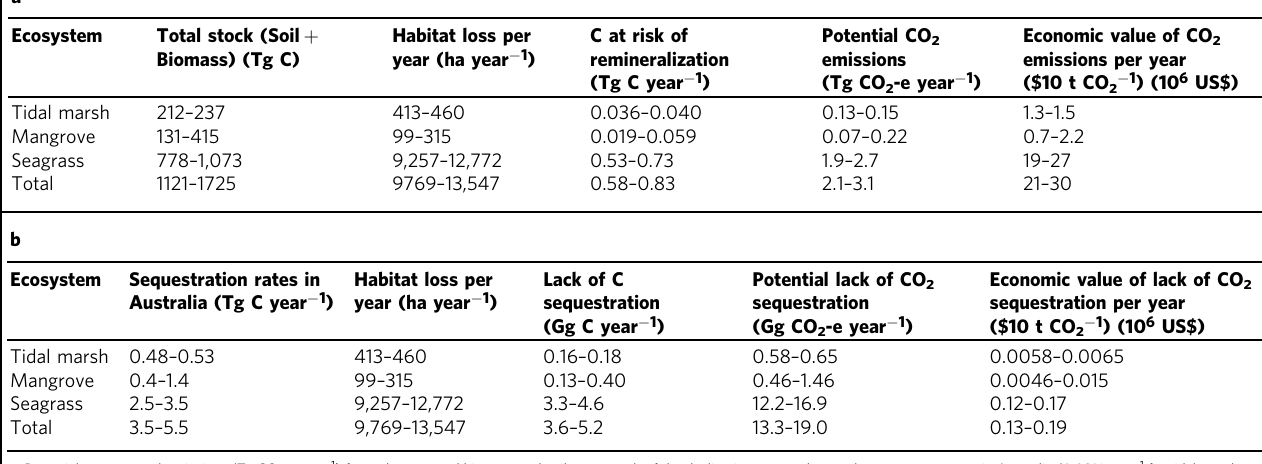
Table 3 Potential annual CO 2 emissions from loss of Australian vegetated coastal ecosystems and economic